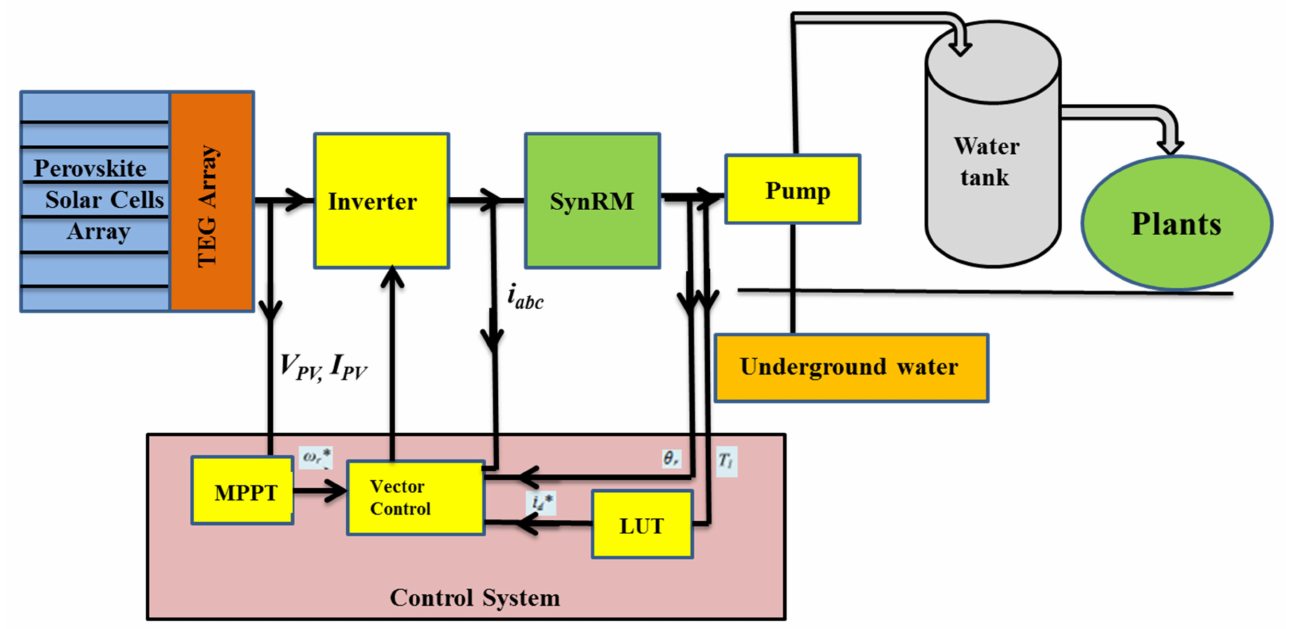
Figure 8. The complete proposed system schematic